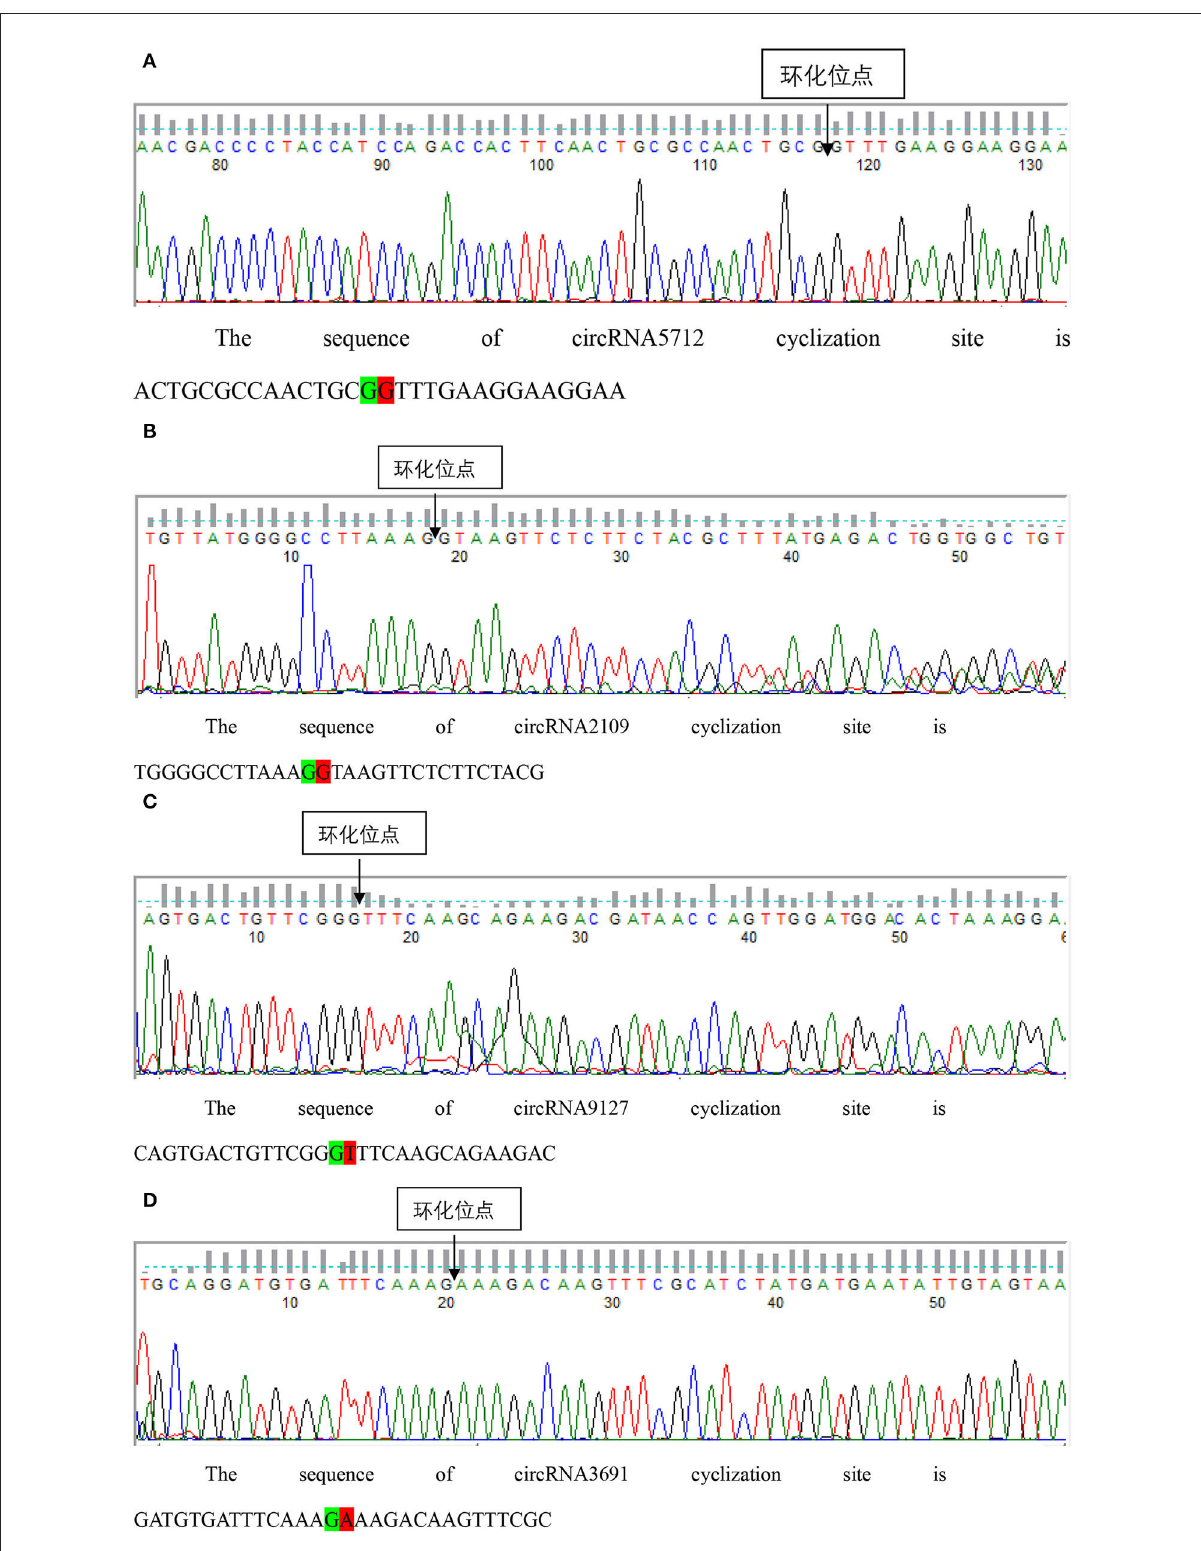
FIGURE9 Sanger sequencing was used to detect the structure of each circRNA. Panels (A–D) represent the results of Sanger sequencing circRNA5127, circrna2109, circRNA9127, and circRNA3691, respectively.